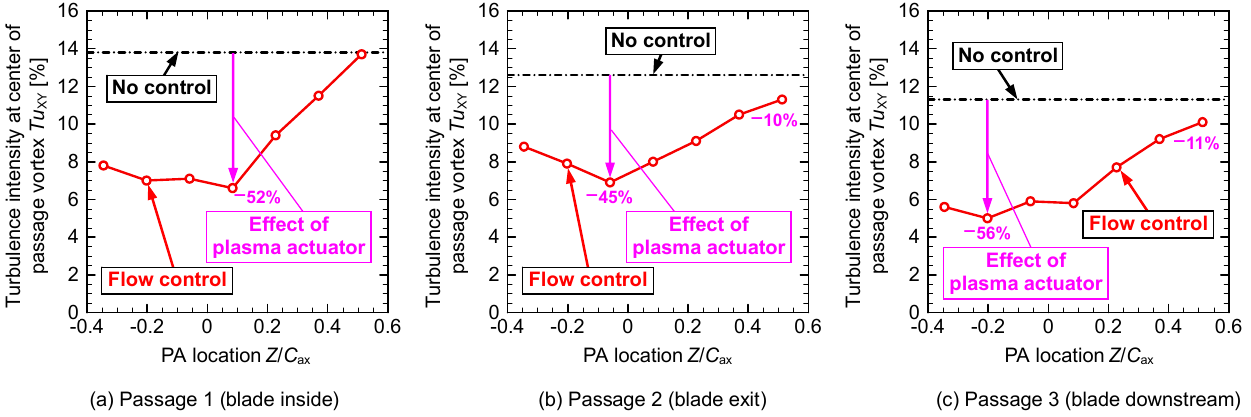
Figure 13. Effect of the plasma actuator location on turbulence intensity at the center of the passage vortex (Re out = 1.8 × 10 4 ).